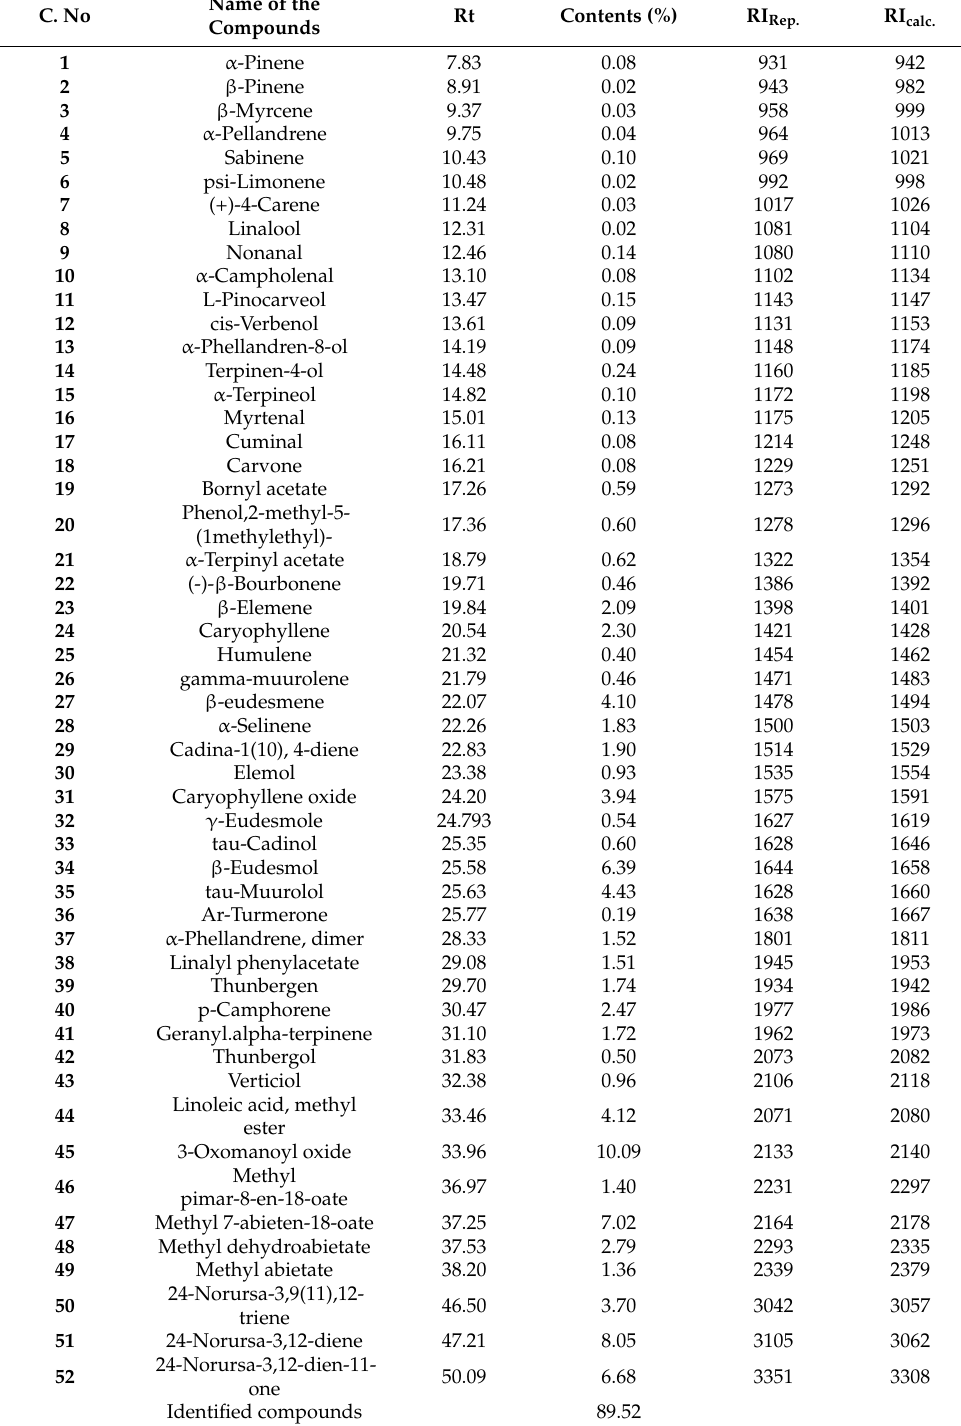
Table 1. GC-MS detected EOs of S. edelbergii